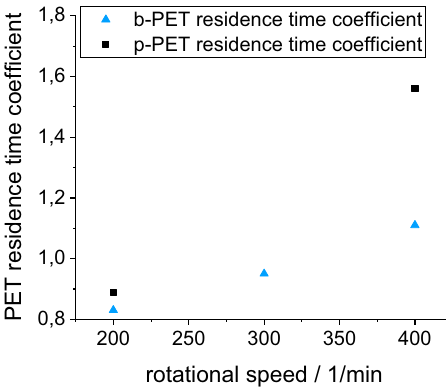
Figure 7: Residence time coe ffi cients of b - PET and p - PET.